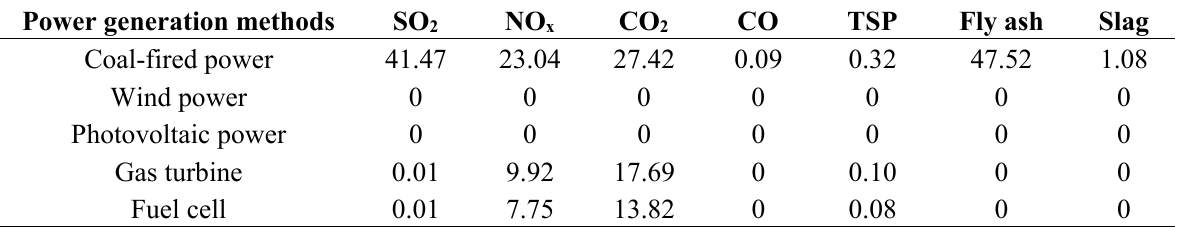
Table 1. Costs of environmental values of various pollutants (Chinese Yuan (CNY)/MWh). Power generation